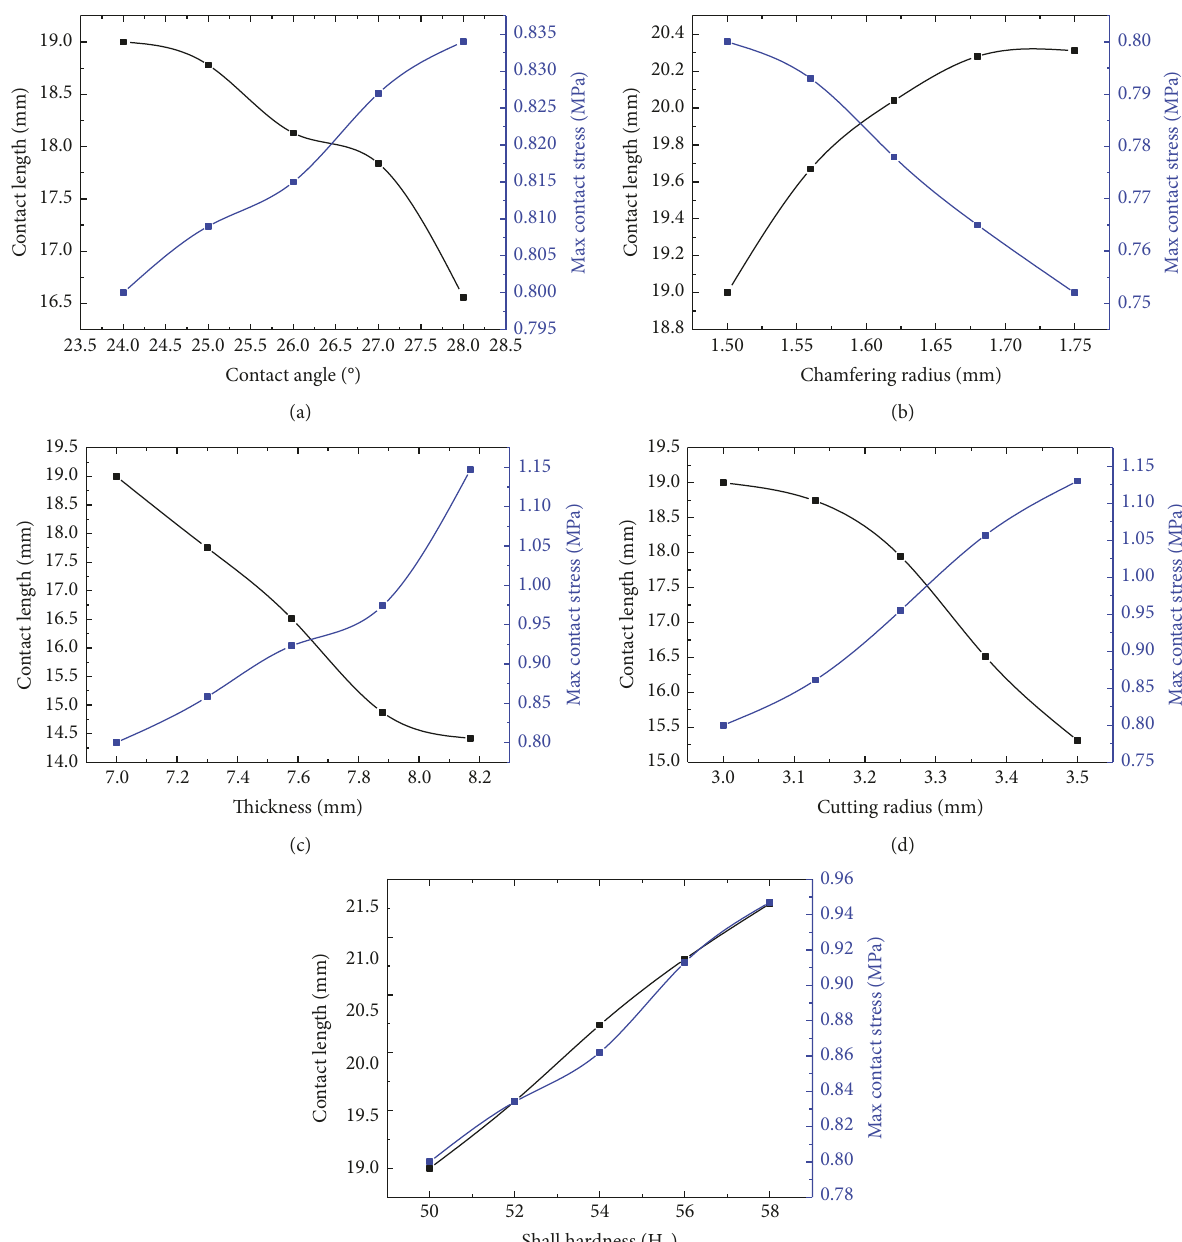
Figure 31: Influence law of key parameters on contact pressure and contact length. (a) Contact angle. (b) Chamfering radius. (c) Thickness. (d) Cutting radius. (e) Shall